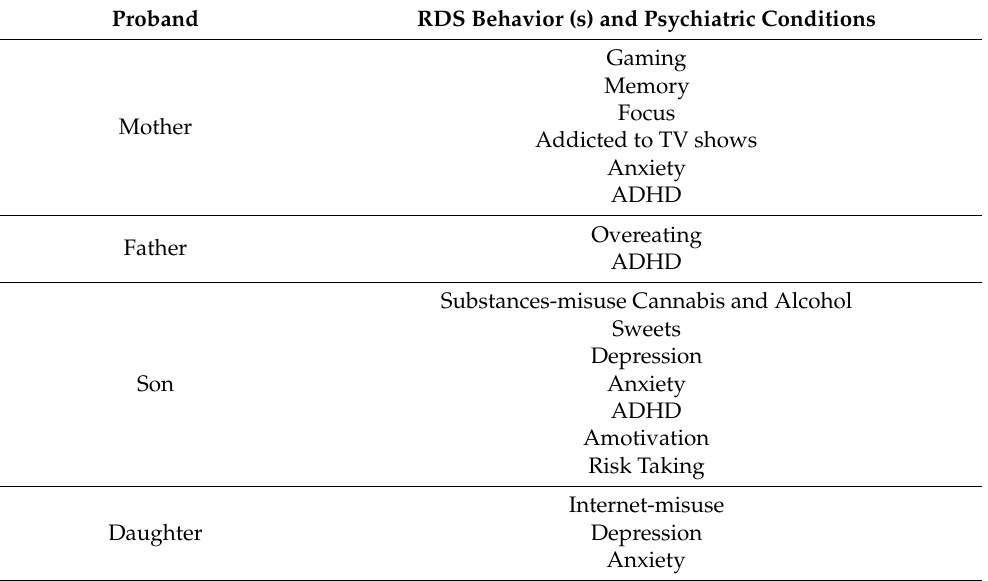
Table 13. Summary of family RDS behavior (self-reported but backed previously diagnosed by a